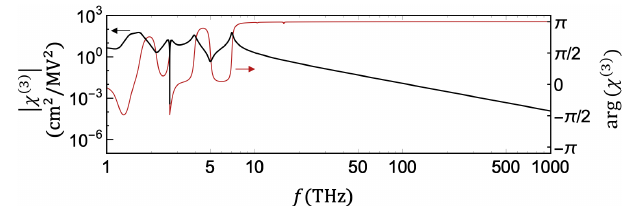
TABLE I. Coupling coefficients for SrTiO 3 used in Figs. 4 and 6. The reduced mass and effective charges for the high- and